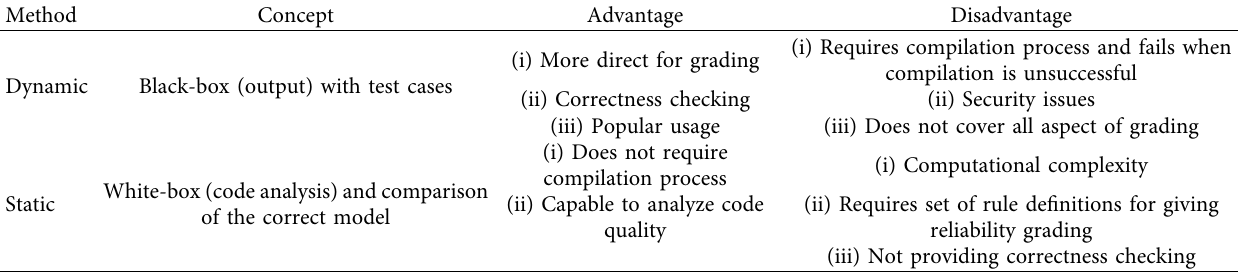
Table 2: Dynamic versus static analysis in the automatic grading